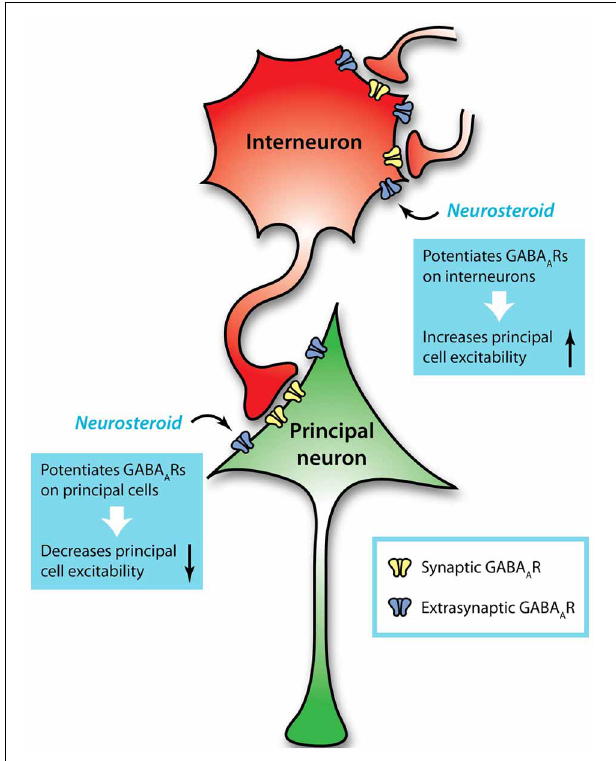
FIGURE 1 | Extrasynaptic GABA A Rs mediate tonic conductances in principal neurons and interneurons. Interneurons regulate the activity of principal cells through GABAergic transmission, but are in turn regulated by GABAergic input from other interneurons. This additional level of GABAergic signaling introduces complexity to understanding neuronal excitability and its modulation. For example, neurosteroids can act on GABA A Rs, especially extrasynaptic receptors that contain a δ subunit, to potentiate GABAergic inhibition on principal neurons and diminish their excitability. Simultaneously, neurosteroids can potentiate GABAergic inhibition on interneurons, thus disinhibiting the principal neurons and enhancing their excitability. These opposing effects, combined with the variability in GABAergic inhibition across cell types and brain regions, present complications when considering GABA A Rs as therapeutic